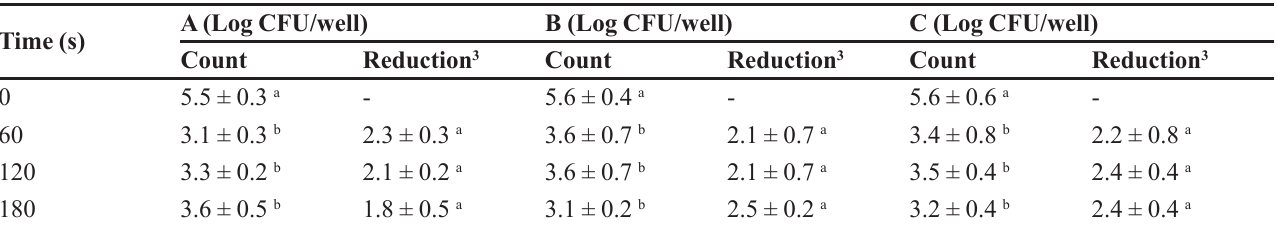
TABLE II - Culturable cell counts and respective reductions of biofilm-producing L. monocytogenes isolates (A-C 1 ) on polystyrene microplates, after treatments with peracetic acid (0.5%) at different contact times 2